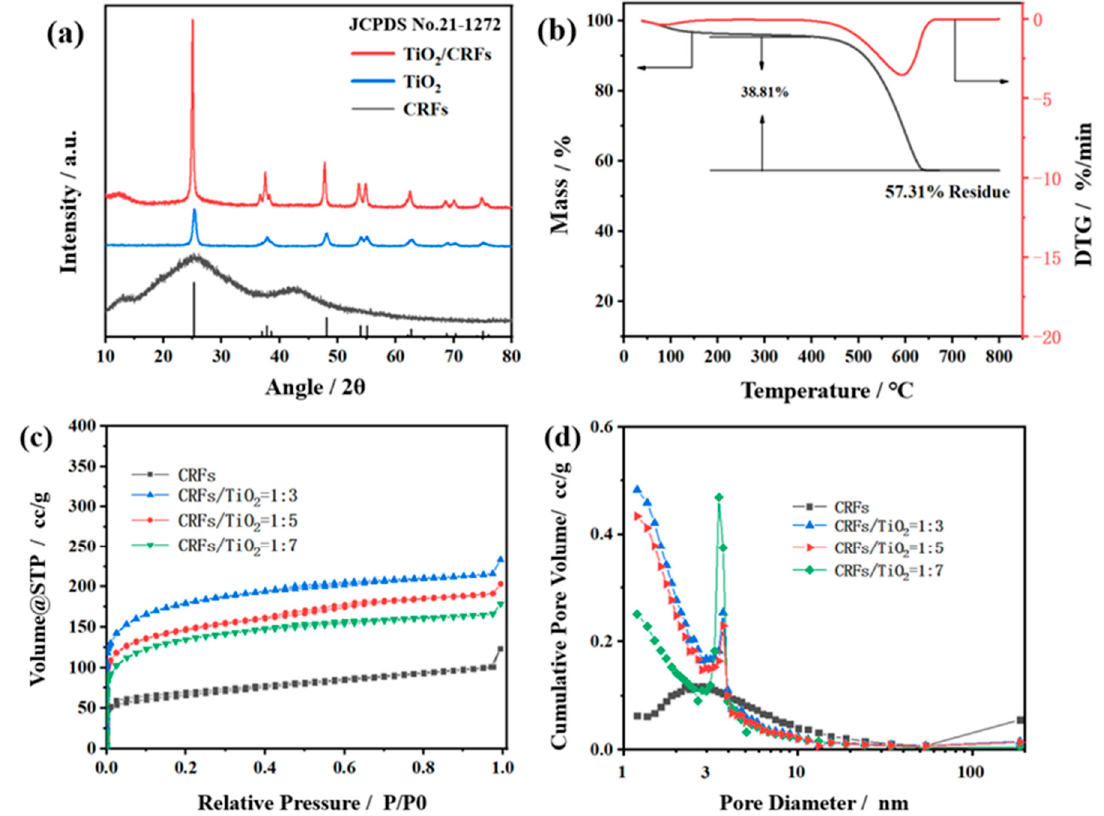
Figure 5. ( a ) XRD patterns of CRFs, TiO 2 and TiO 2 /CTFs; ( b ) TG/DTG curves of TiO 2 /CRFs; ( c ) Nitrogen adsorption–desorption isotherms and ( d ) Pore size distribution for TiO 2 /CRFs.